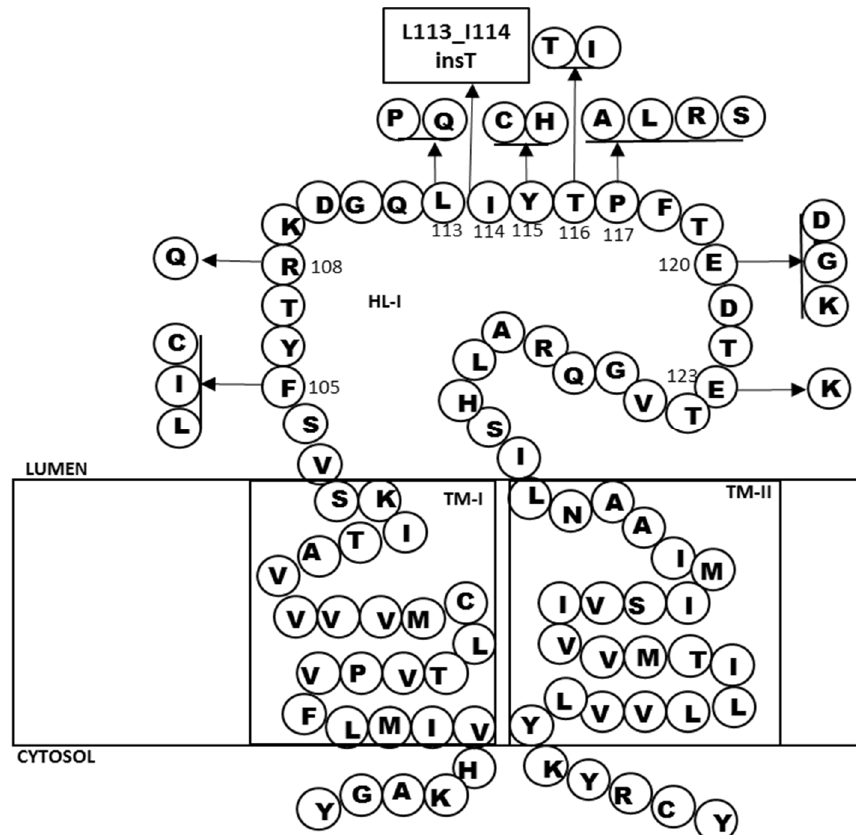
Figure 5. Mutations, located in the HL-I of PSEN1 protein.